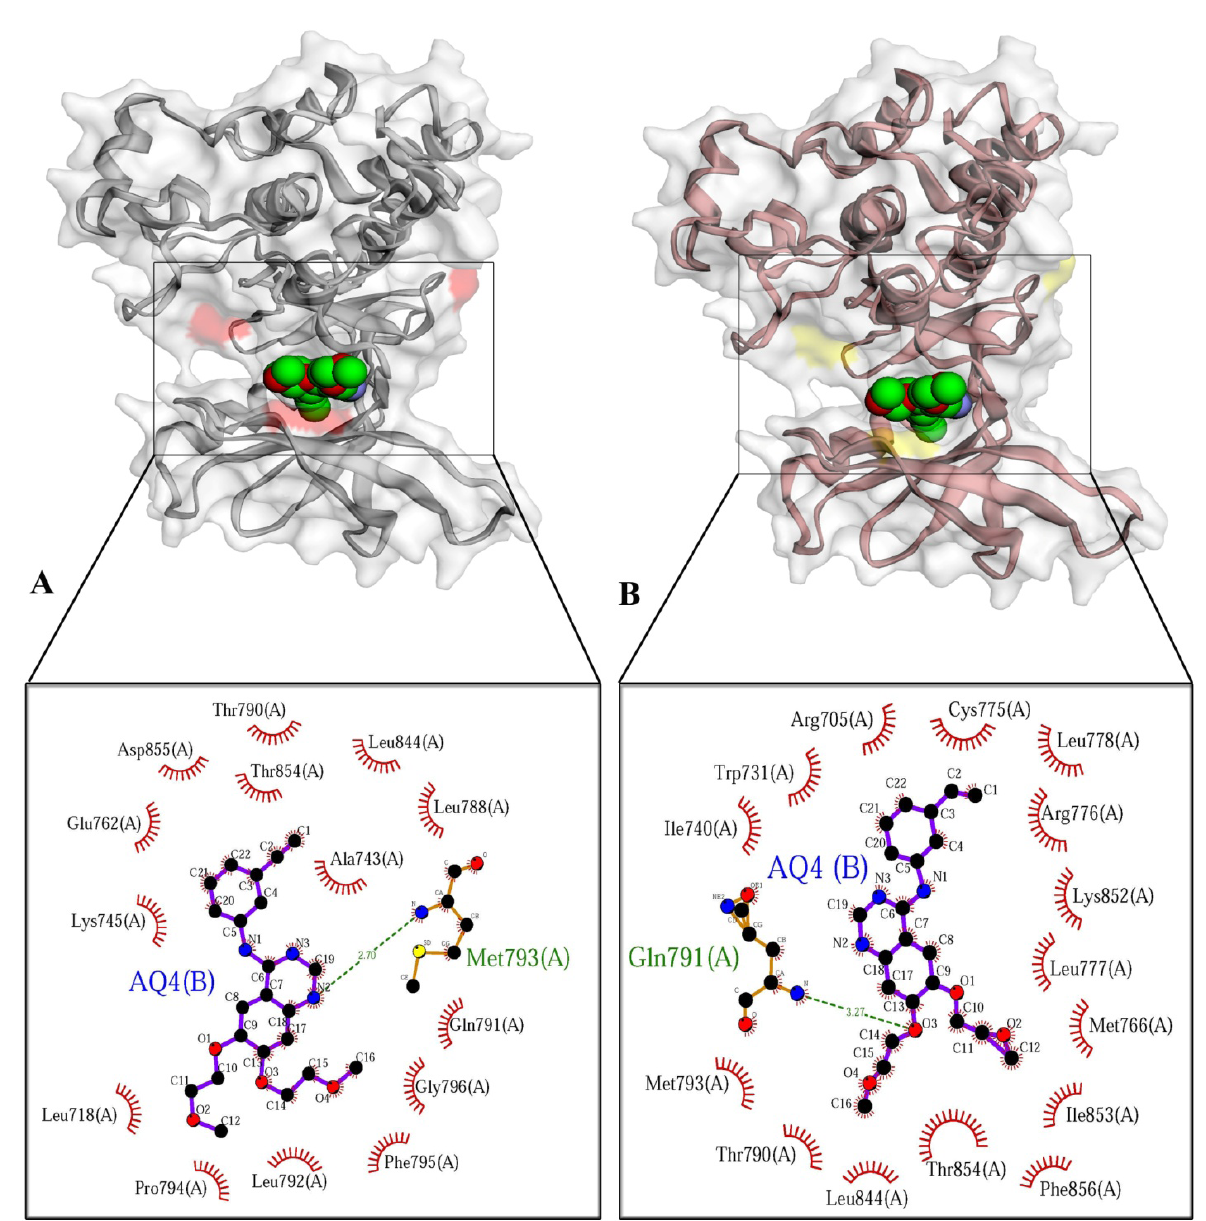
Figure 2: Ligplot analysis of erlotinib binding with the triple mutant and wild-type EGFR. A ) Wild-type, and B ) EGFR-AHR form. EGFR residue in H-bond is depicted in orange (chain A) and AQ4 is (erlotinib) in blue (chain B). The green dashed lines refer to hydrogen bonds. The non-stick residues in red correspond to hydrophobic contacts of EGFR. Mutations have changed the hydrophobic interactions of erlotinib compared to the